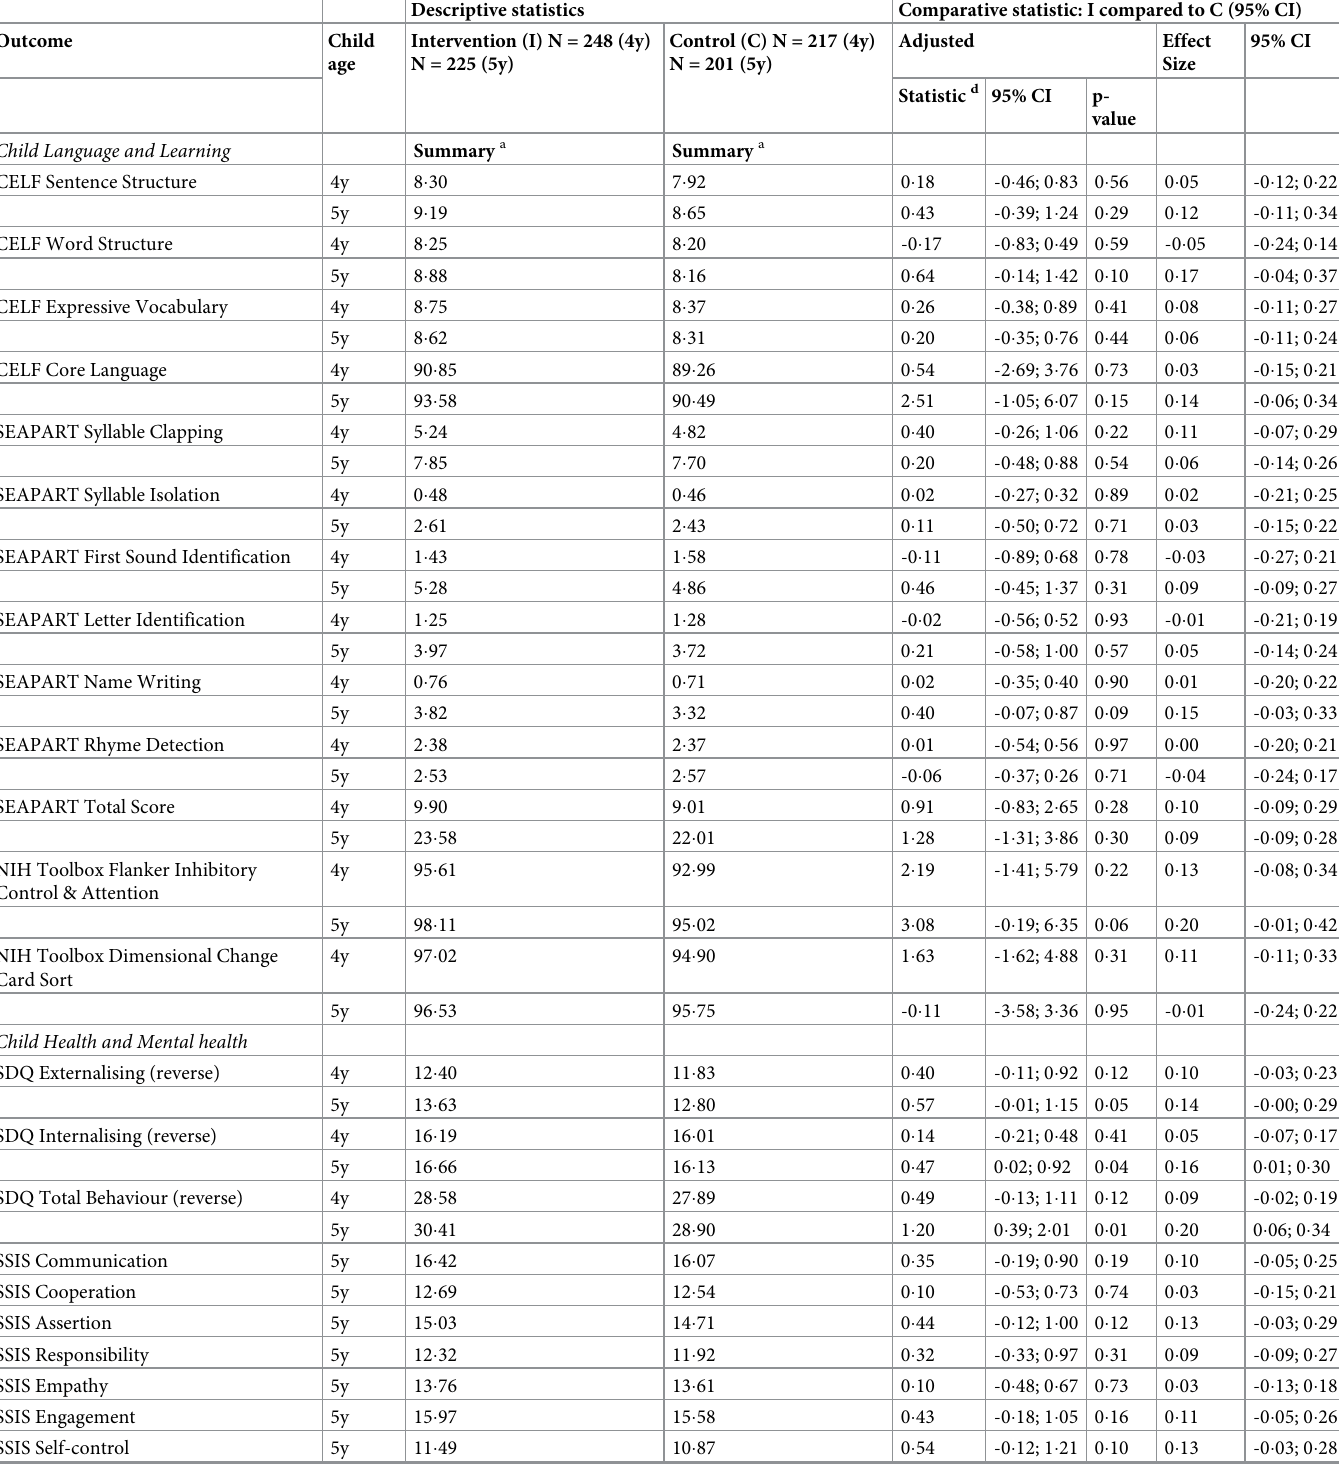
Table 3. Results of adjusted regression analyses comparing the two trial arms on child outcomes at age 4 and 5 years, using multiply imputed and inverse probabil- ity weighted